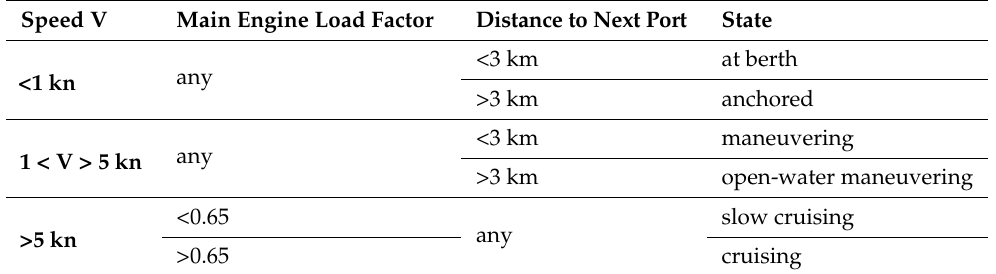
Table 1. Classification of operating state according to vessel speed and distance to the next port. Speed V